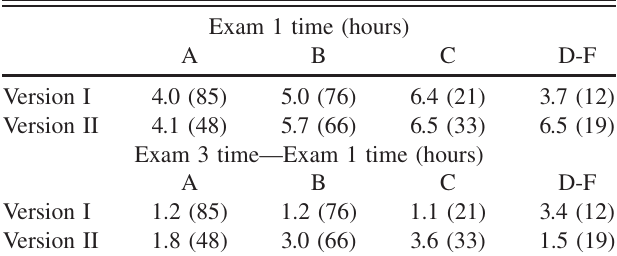
TABLE VIII. Change in study behavior during semester. Shown are the number of hours spent preparing for hourly exams separated by the test grade of the student going into the third exam. Also shown is the difference in the number of hours spent preparing for exam 3 and exam 1. The number in parenthesis is the number of students included in the